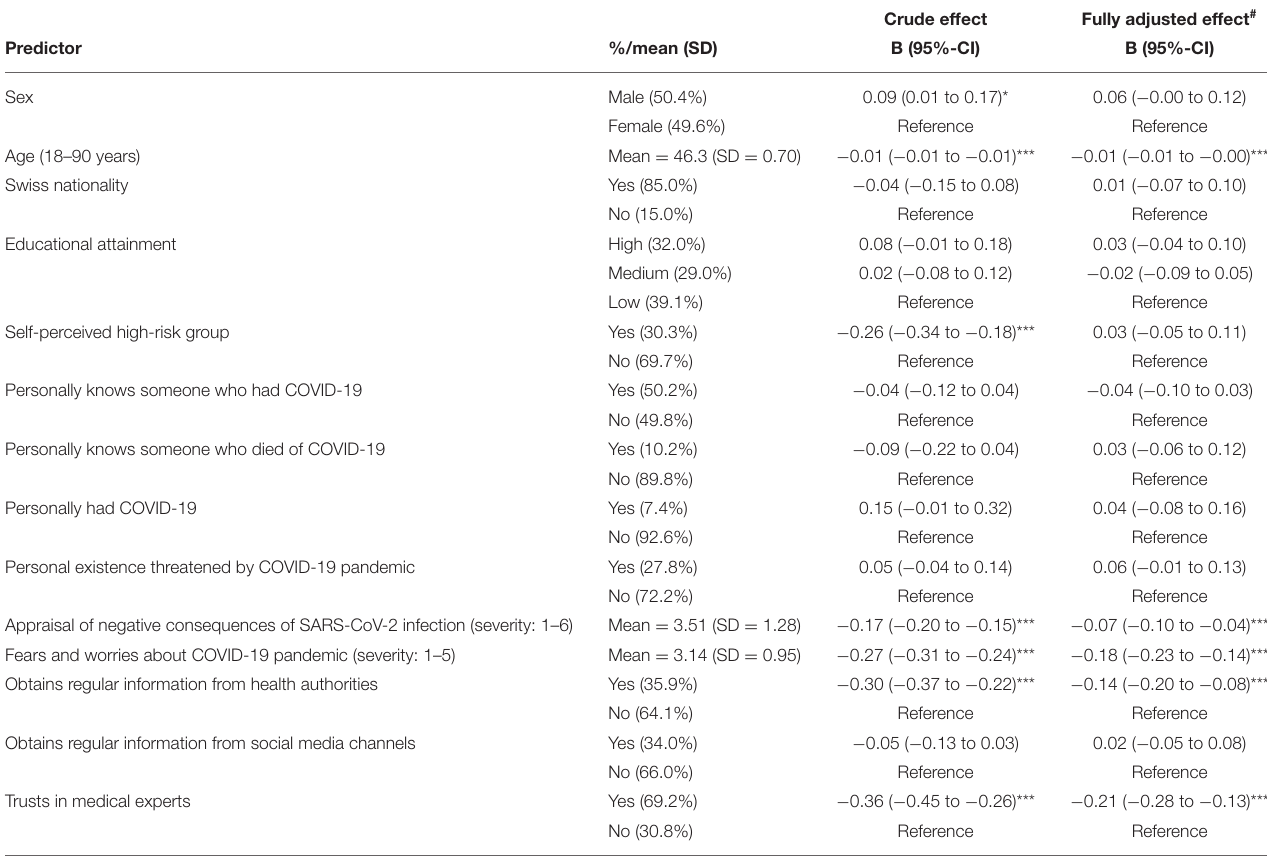
TABLE 2 | Predictor variables associated with non-compliance with non-pharmaceutical interventions to mitigate the spread of SARS-CoV-2 ( n =